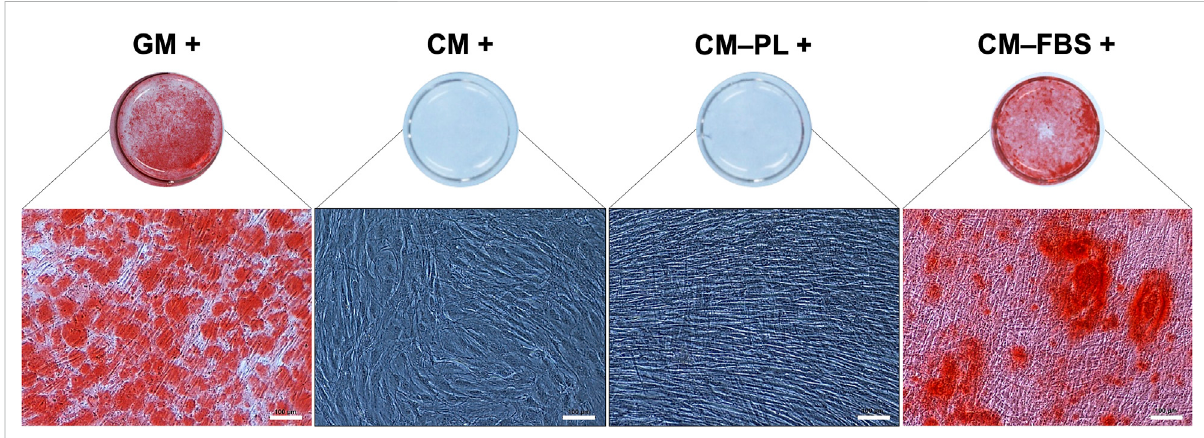
FIGURE 3 In vitro mineralization assay. Representative images of Alizarin red S stained BMSC after 14 days ( n = 2 donors; 3 experimental replicates per donor), scale bars 100 μ m. +, osteogenic induction added; GM, growth media; CM, conditioned media, PL, platelet lysate; FBS, fetal bovine